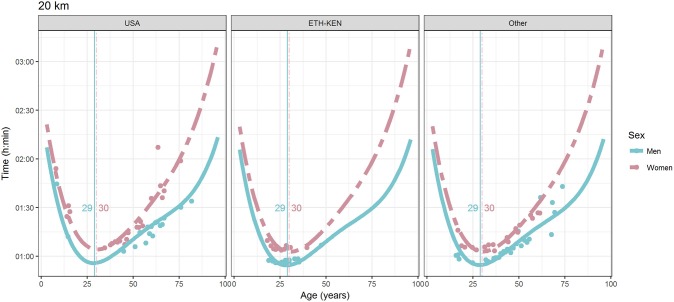
World record in 20 km by sex, age (in years), and country. Points were observations. Curves represented quartic degree polynomial regression. Vertical lines with numeric labels were the ages at peak performance.